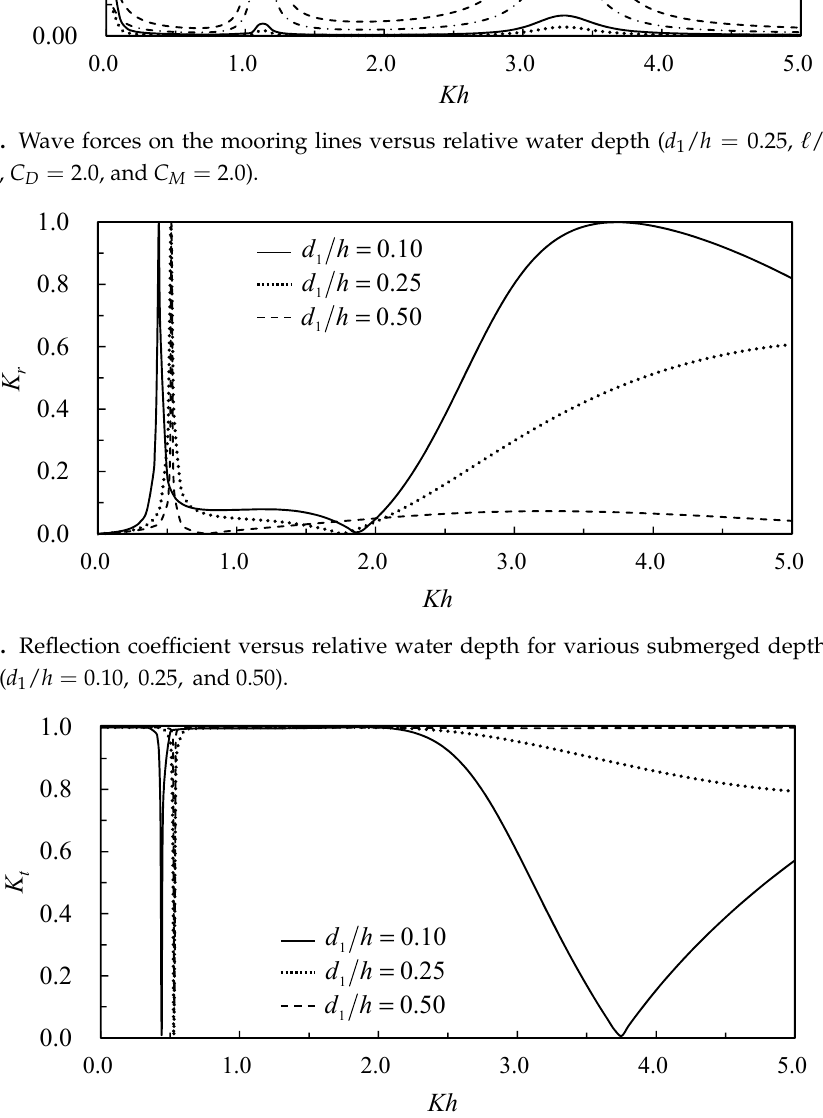
structure ( d 1 / h = 0.10, 0.25, and